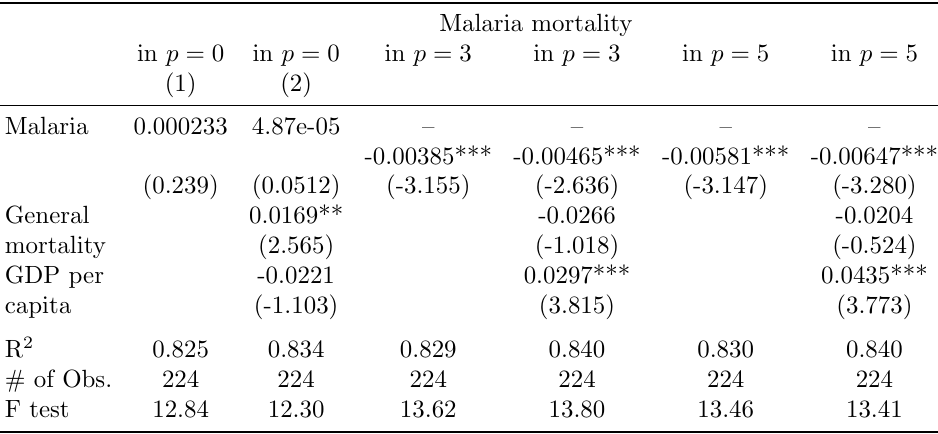
Table 4: Malaria and height (OLS estimates) Malaria